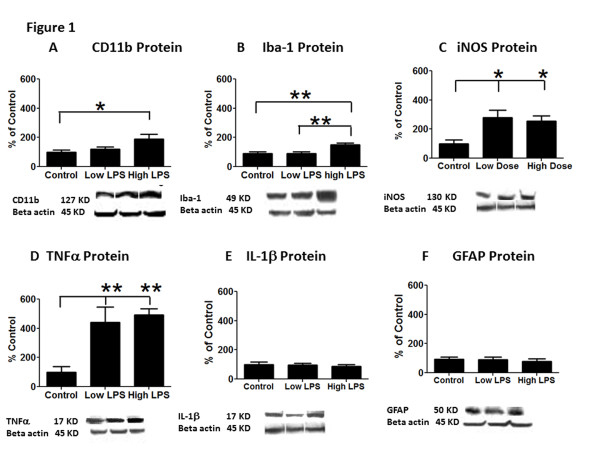
Protein levels of (A) CD11b, (B) Iba-1 (C) iNOS, (D) TNFα, (E) IL-1β and (F) GFAP (with representative immunoblots) in control, low- and high-dose LPS rat brain. The protein level was determined in a homogenate of cerebrum and cerebellum, as in all subsequent figures (see methods). Data are ratios of optical densities of protein to β-actin, expressed as percent of control. Comparisons between LPS groups were made using one-way ANOVA, mean ± SEM (n = 8). *p < 0.05.